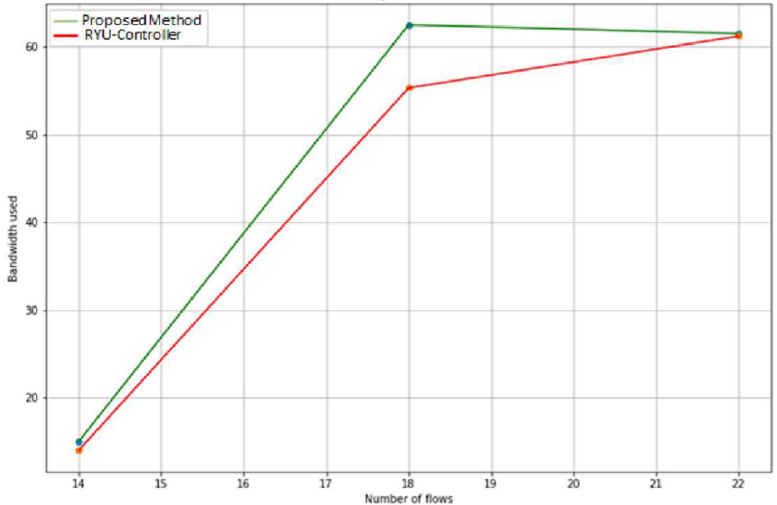
Figure 12. Comparison Between the Bandwidth Used in the Proposed Method and the Ryu Controller for the Two Types of Flows.